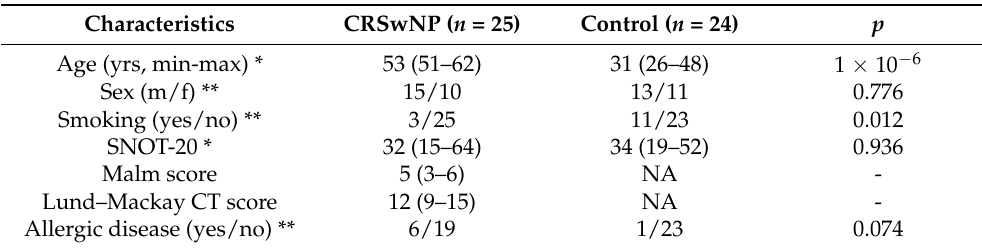
Table 1. Patients’